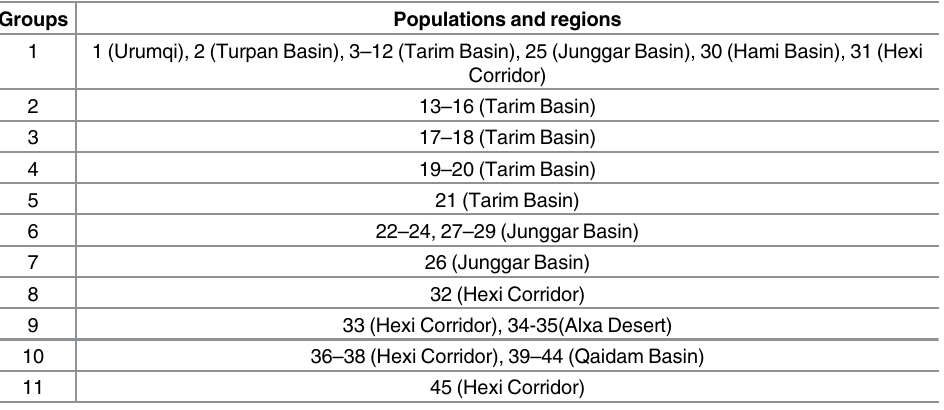
Table 1. Results of spatial analysis of molecular variance corresponding to K = 11.